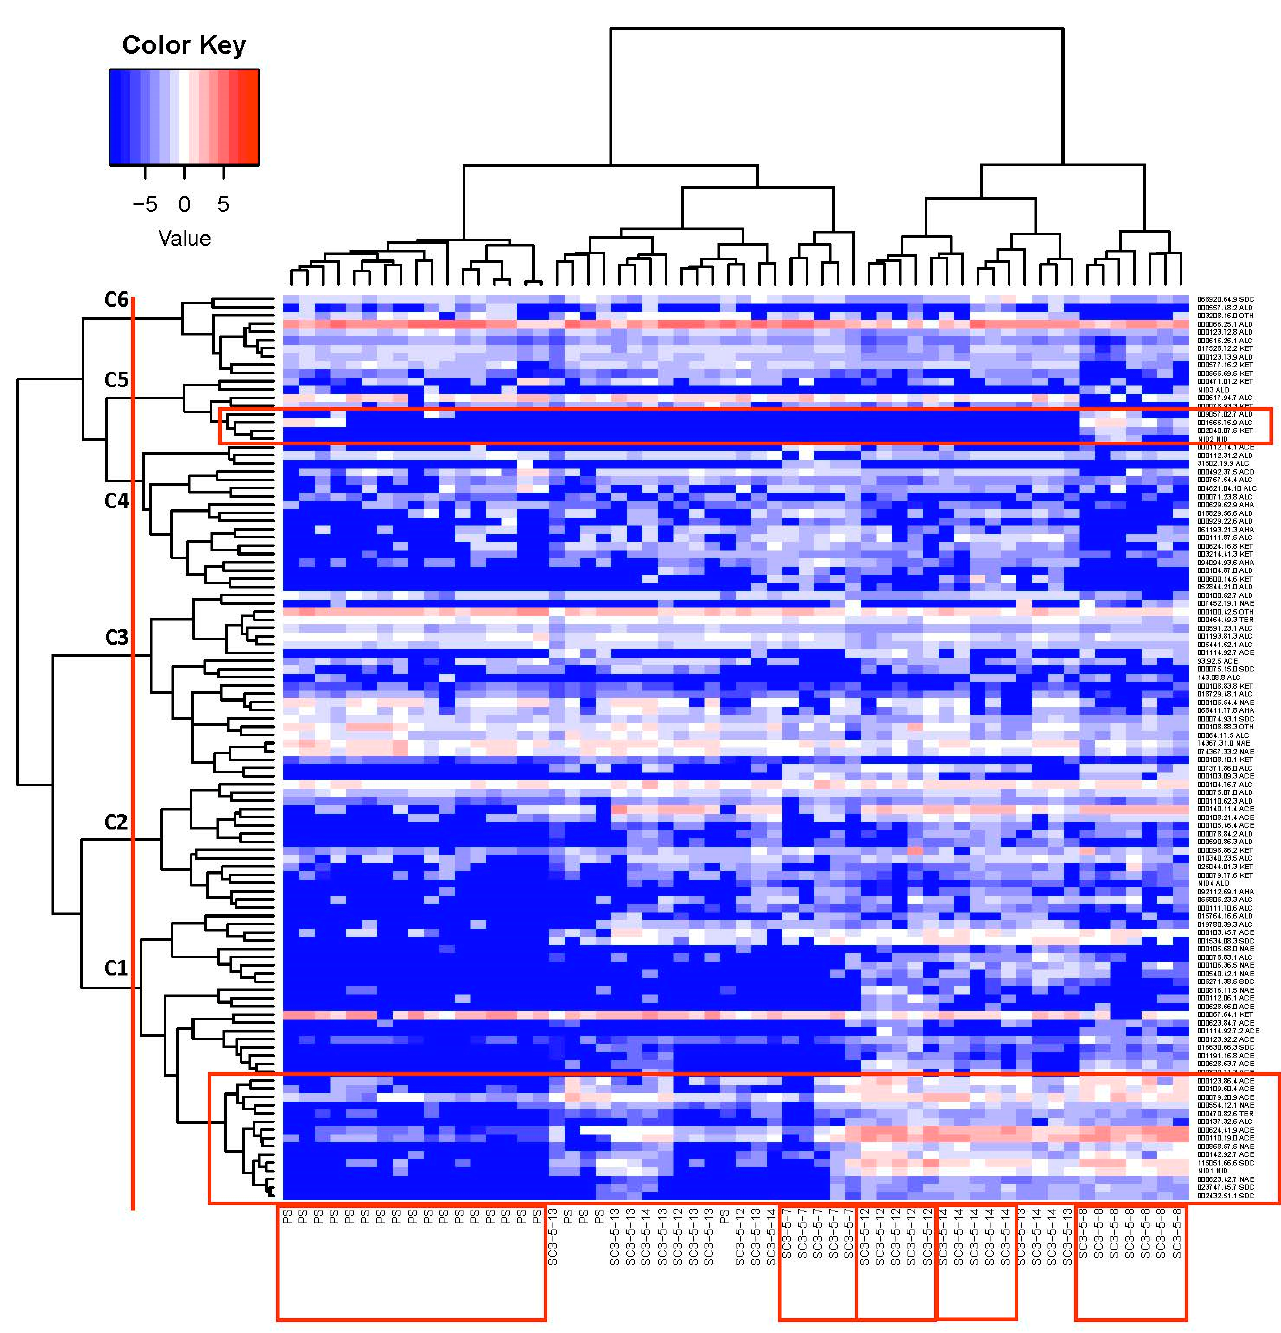
Figure 8. Heatmap for two-way hierarchical clustering applied to melon fruits and their aroma volatiles analyzed for the Near-Isogenic Lines (NILs) with introgression of melon chromosome 3 (SC3-5-7, SC3-5-8, SC3-5-12, SC3-5-13, and SC3-5-14) and the parental control ‘Piel de Sapo’ (PS). Den- drograms obtained by Ward’s hierarchical clustering method were applied to the log 2 -transformed data analyzed. The individual volatiles are plotted by their respective CAS numbers (dots instead of dashes) on the right of the heatmap.